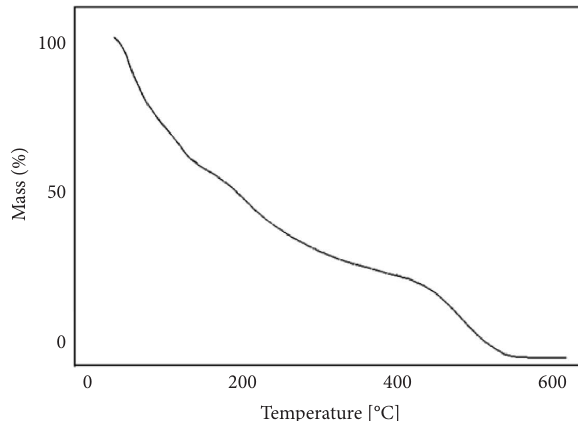
Figure 10: Termogravimetric analysis (TGA) of